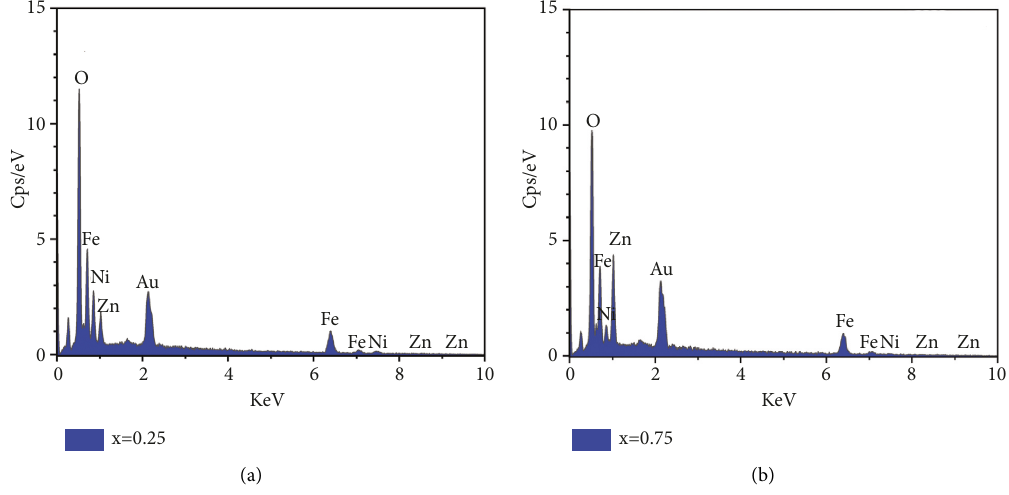
Figure 10: The EDS spectrum of (a) Ni